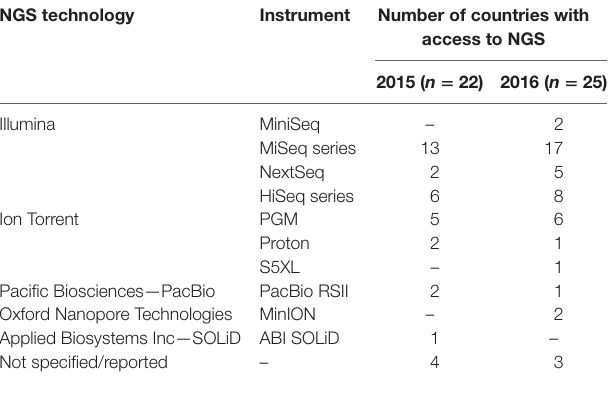
Table 1 | Number of EU/EEA countries with one or more national public health reference laboratories having access to next-generation sequencing (NGS) technologies for routine public health operations, by technology and instrument used, 2015–2016. ngs technology